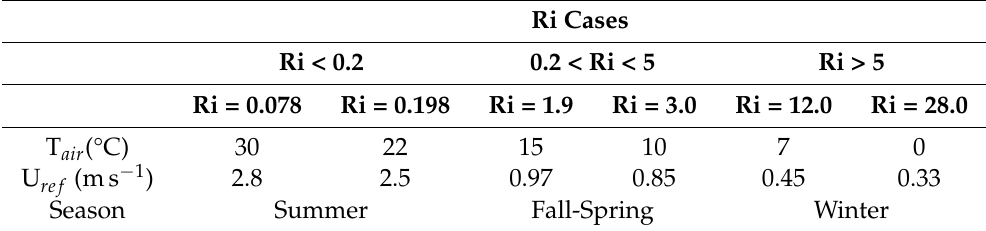
Table 4. Detailed Ri values and corresponding velocities and temperatures.